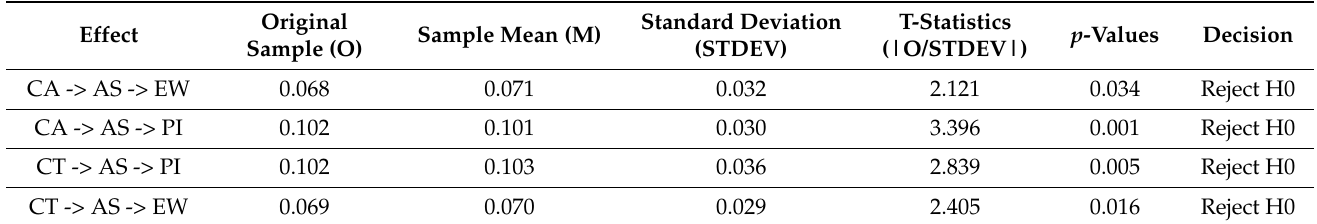
Table 9. Specific indirect effect (mediation), mean, STDEV, T-values, and p